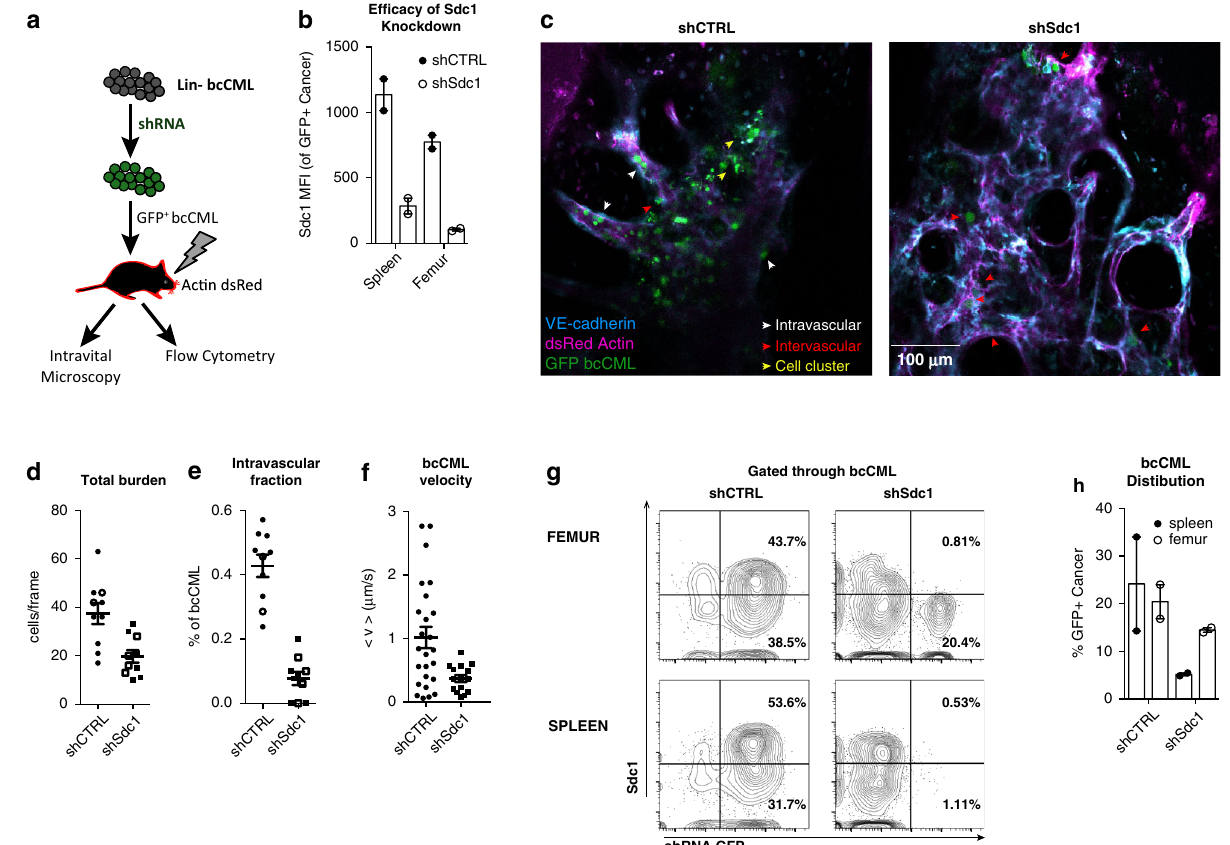
Fig. 6 Syndecan-1 controls the spatiotemporal dynamics of bcCML in vivo. a Schematic illustrates the experimental approach used to assess the impact of Sdc1 loss on the dynamics of bcCML in vivo. bcCML cells infected with shCTRL or shSdc1were transplanted into irradiated dsRed NOD SCID recipient mice. The calvarium of recipient mice was live imaged 10 – 15 days post-transplantation, after which the femurs and spleens were analyzed by fl ow cytometry. b Con fi rmation of Sdc1 knockdown in bcCML cells infected with shSdc1 as quanti fi ed as a reduction in Sdc1 MFI by fl ow cytometry. Signi fi cance from shCTRL within a location ( n = 2 mice per group). c Representative live animal imaging of dsRed recipient mice transplanted with shCTRL or shSdc1 bcCML; green = shRNA vector, blue = VE-Cadherin, magenta = Actin dsRed, white arrowhead shows cells within the vasculature, red arrowhead shows cells outside of vasculature within the marrow, yellow arrowhead shows cell clusters (See also Supplementary Movies 2 and 3). d Quanti fi cation of GFP + bcCML burden from live animal imaging of bone marrow (xyz confocal stacks, n = 2 animals per group, open and closed symbols denote separate animals, n = 10 fi elds of view per group). e Quanti fi cation of GFP + bcCML residing within vasculature determined by live animal imaging (xyz confocal stacks, n = 2 animals per group, open and closed symbols denote separate animals, n = 10 fi elds of view per group). f The average velocity of GFP + bcCML determined by measuring in vivo cell migration in real time (xyt confocal stacks, n = 2 animals per group, ≥ 3 fi elds of view per mouse, shCTRL n = 25 cells, shSdc1 n = 15 cell). g Representative fl ow cytometry plots show the distribution of bcCML in the femur and spleen of mice used in live animal imaging studies in ( b – f ). Percentages of shRNA-infected Sdc1 + and Sdc1 − bcCML cells are indicated. h Quanti fi cation of tumor burden in femur and spleen of mice used in the live animal imaging studies ( n = 2 animals per group). Two-tailed unpaired Student ’ s t- tests were used to determine statistical signi fi cance. Source data are provided as a Source Data